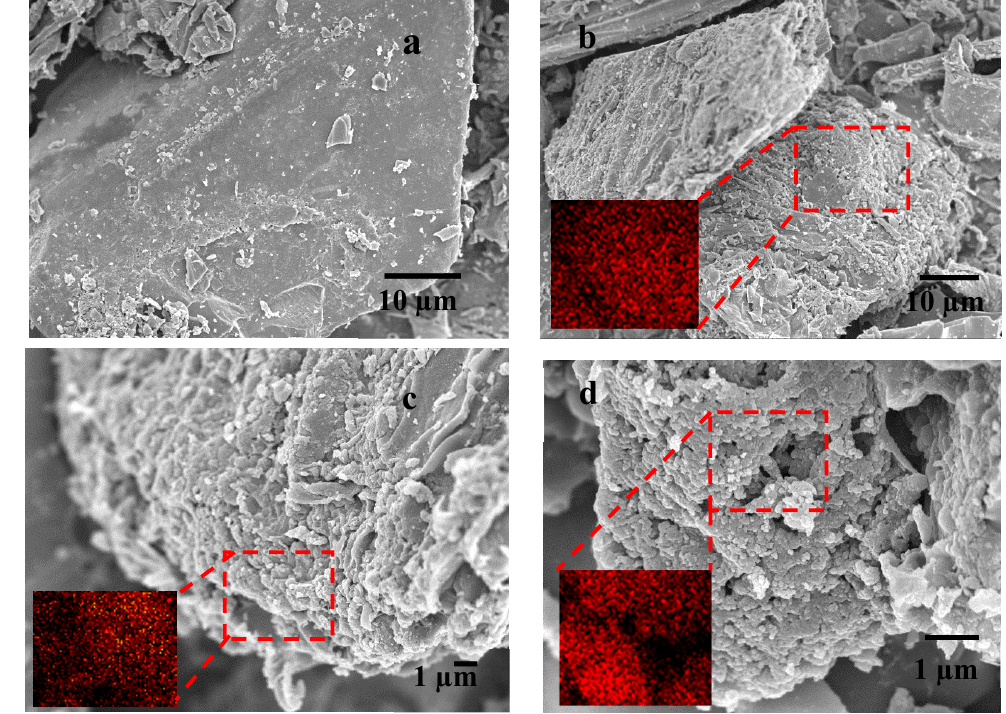
Figure 2. SEM images of ( a ) C-900, ( b ) Ni@C-700, ( c ) Ni@C-800, ( d ) Ni@C-900 (insets are the distribution of nickel particles within the